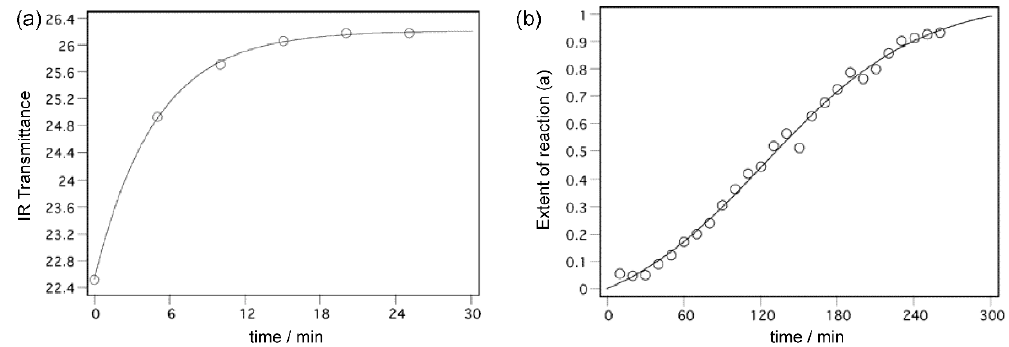
Figure 1. Kinetics of the solid-state dimerization of p -bromonitrosobenzene followed by ( a ) time-resolved IR spectroscopy (exponential kinetic curve) and by ( b ) time-resolved XRPD (sigmoidal kinetic curve). Reproduced with permission from [13]. Copyright 2004 American Chemical Society.